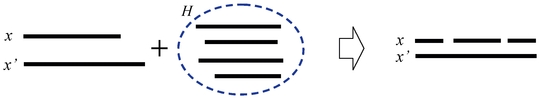
Pairwise alignment using homologous sequences (Problem 12).